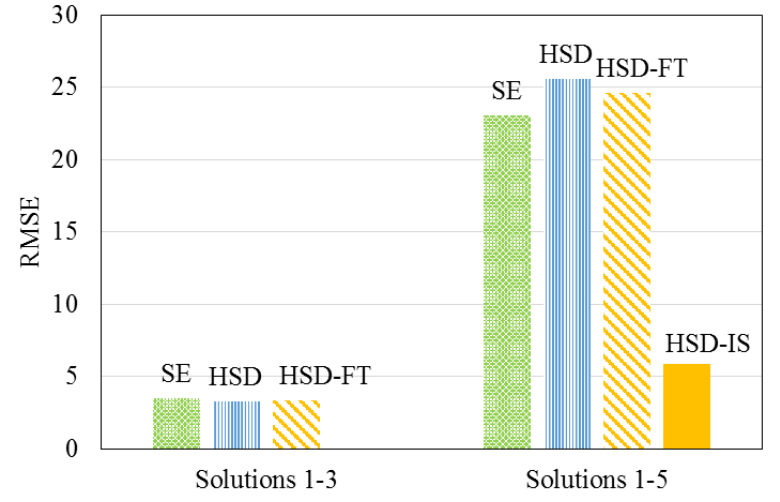
Figure 9. Comparison of models for describing permeate magnesium concentration.